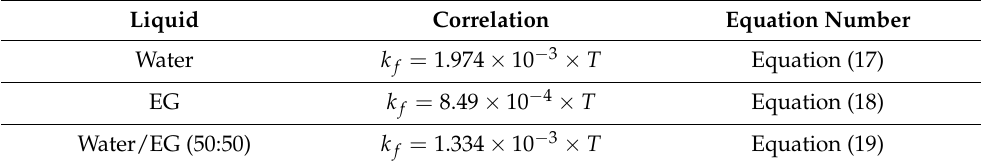
Table 3. Correlations for the thermal conductivity of the base fluids.